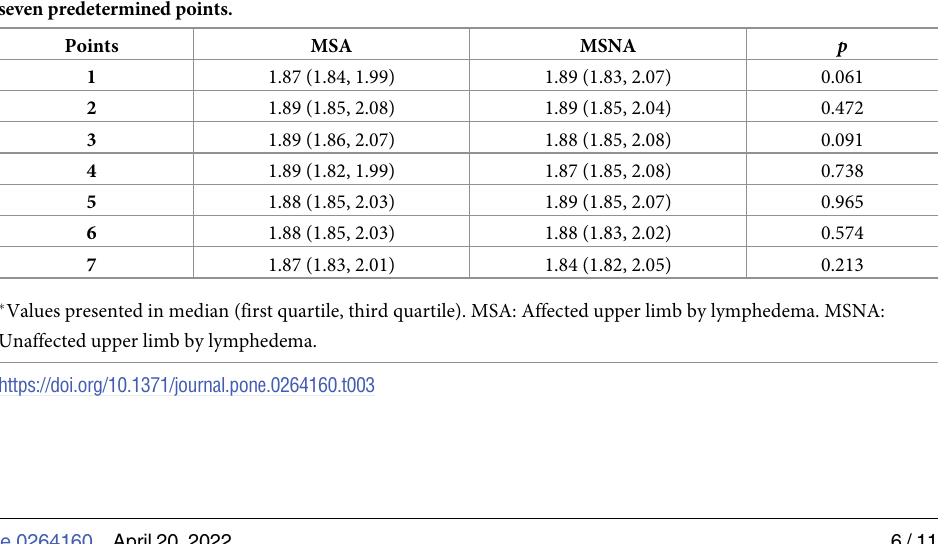
Table 3. Values referring to entropy in the affected upper limb (MSA) and unaffected upper limb (MSNA) at the seven predetermined points. Points MSA MSNA